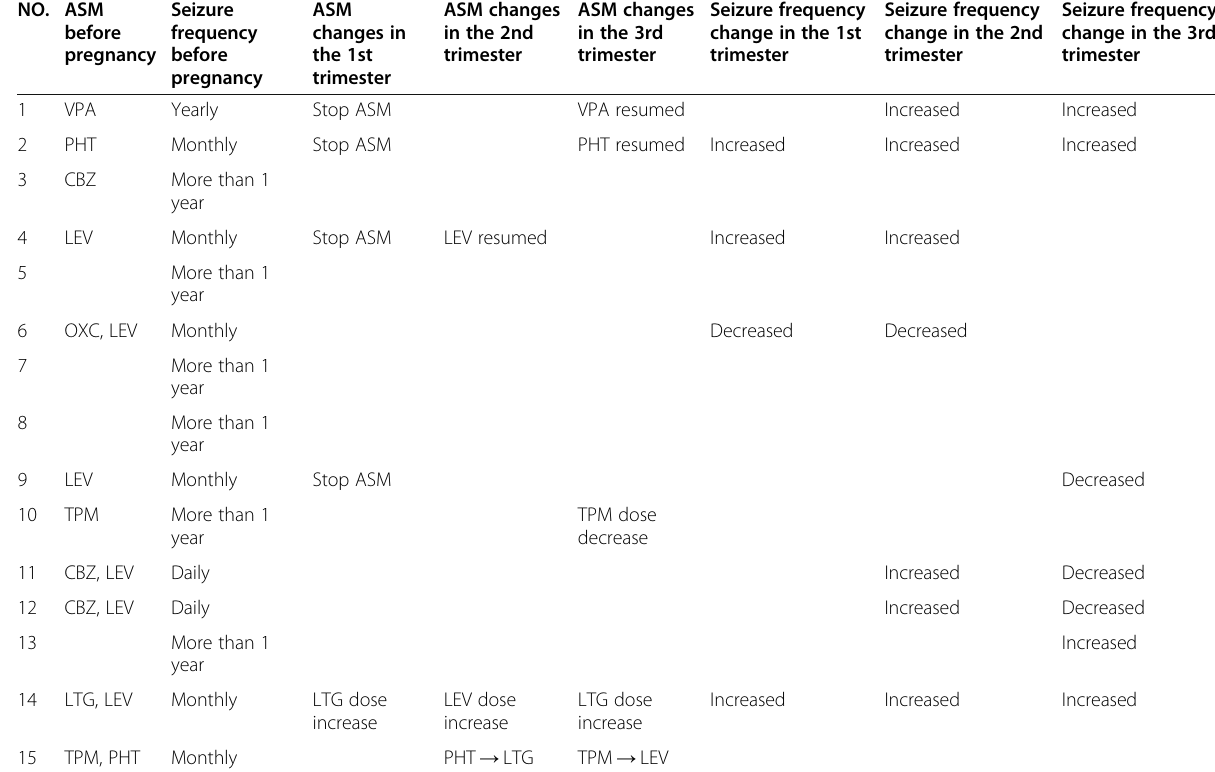
Table. 1 Changes of ASM and seizure frequency during different trimesters NO. ASM